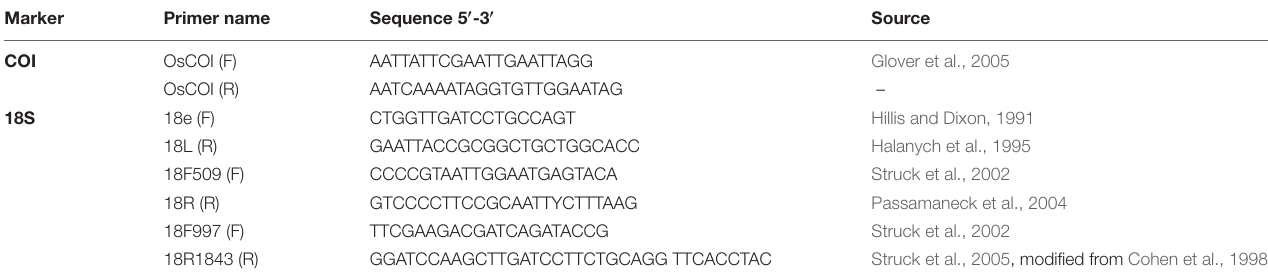
TABLE 1 | PCR and sequencing